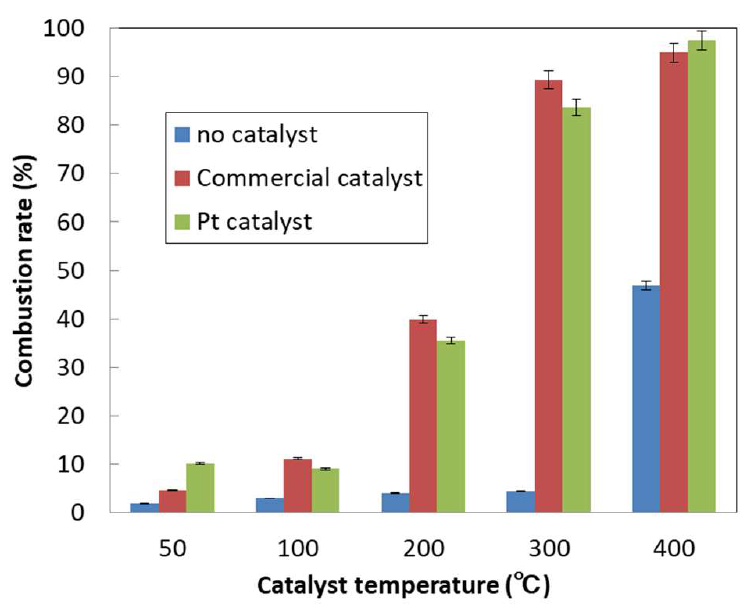
Figure 5. Combustion rate of octane for the catalysts as a function of the catalyst temperature. Table 2. Precious metal nanoparticle utilization efficiency of the catalysts.